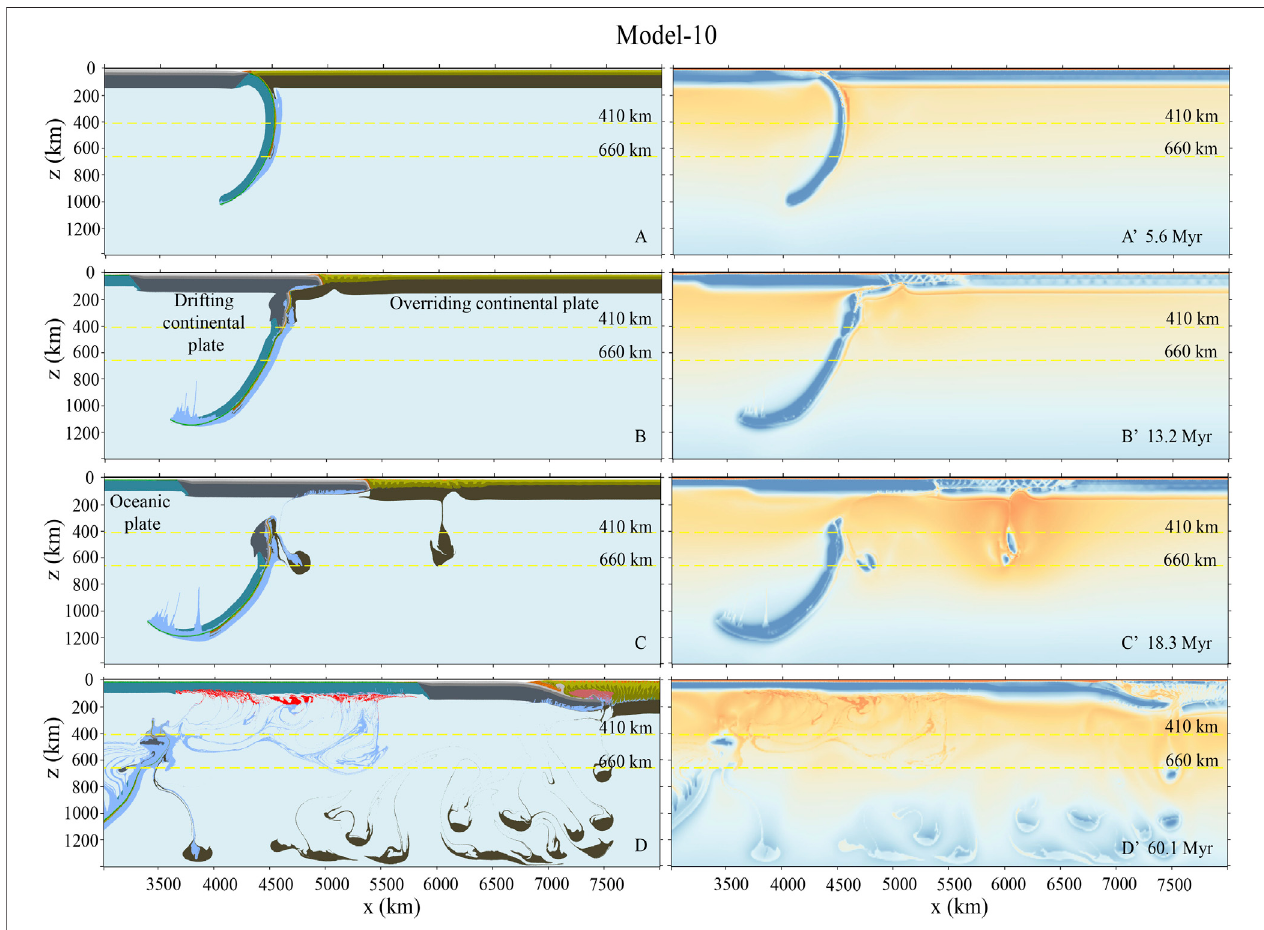
FIGURE 12 | Model-10 evolution with the weakest overriding plate. The plastic friction coef fi cient of the overriding lithospheric mantle is initially λ · sin ( φ ) (cid:2) 0.01 and will decrease linearly to 0.001 with accumulated plastic strain to ε plas = 1 ( Supplementary Table S2 and Supplementary Equation S11 in the supporting information).AlltheotherparametersareidenticaltoModel-9( Figure11 ). (A – D) Thecomposition fi eldevolutionwiththecorrespondingcolorbarisshownin Figure2A . (A ’ – D ’ ) The effective viscosity evolution with the corresponding colorbar is shown in Figure 2B